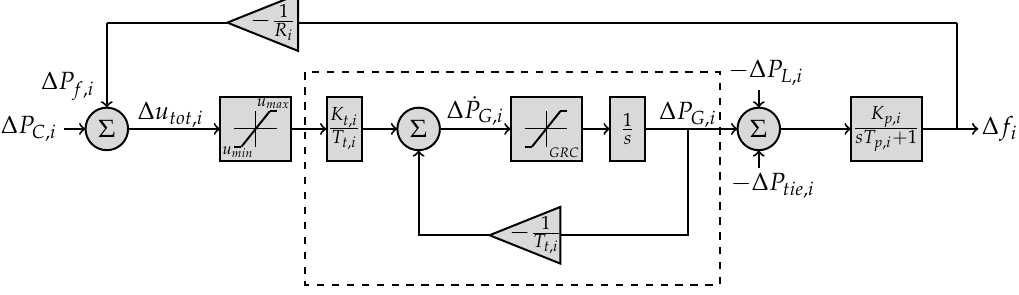
Figure 17. Single block representation of the i -th interconnected area with saturation hard constraint on the total input signal and nonlinear turbine model with